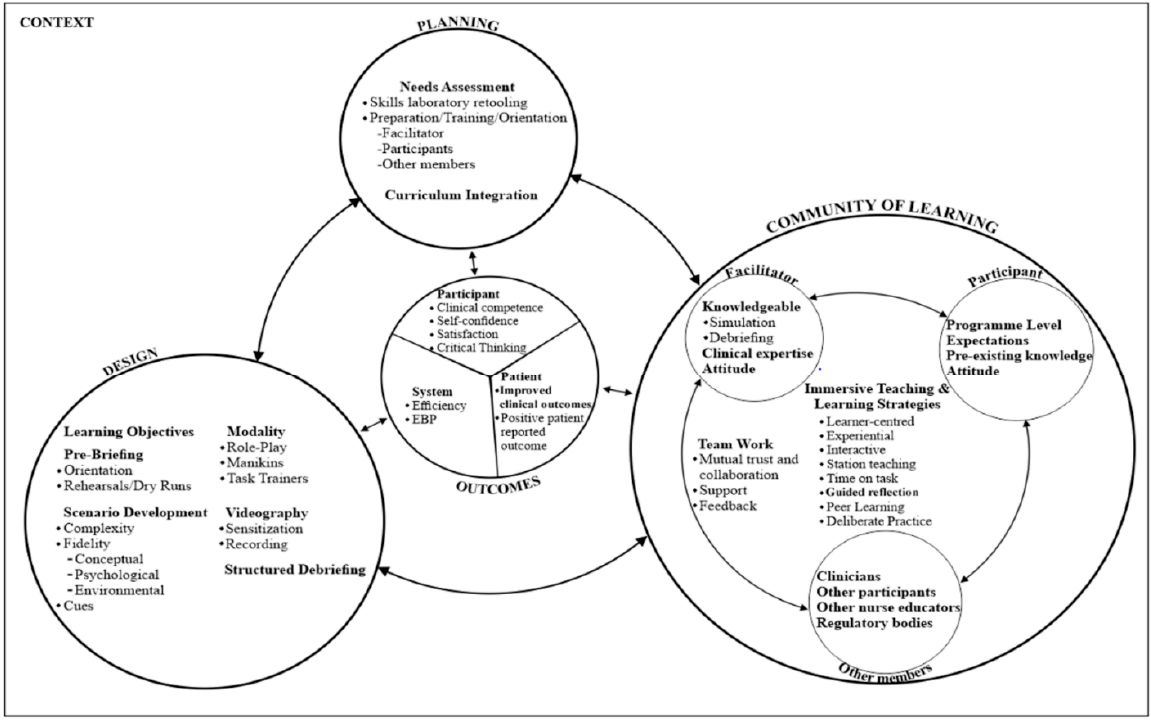
Figure 2. Simulation-based clinical nursing education framework for low-resource